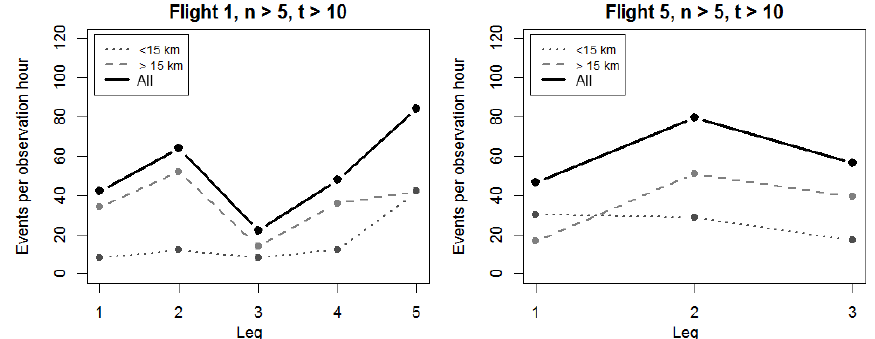
Figure 13. Occurrence rate of significant wave events for each leg of flight 1 and 5 (measurements during turning manoeuvres and aurora events are not included). The results are shown for wavelengths smaller (dotted line) and larger than 15km (dashed line) as well as for the sum of both (solid line). If wavelength and propagation direction are identical for at least six images (parameter n ) separated by 30s at maximum, this wavelength is denoted as a wave event. Wave events must be present for more than 10s at least (time difference between first and last occurrence, parameter t ). The results do not change qualitatively if n and t are